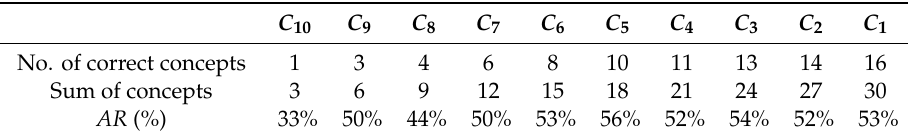
Table 10. Learning achievement results for student 3, who correctly answered Q 1 , Q 3 , Q 4 , Q 7 , Q 9 , Q 10 ,